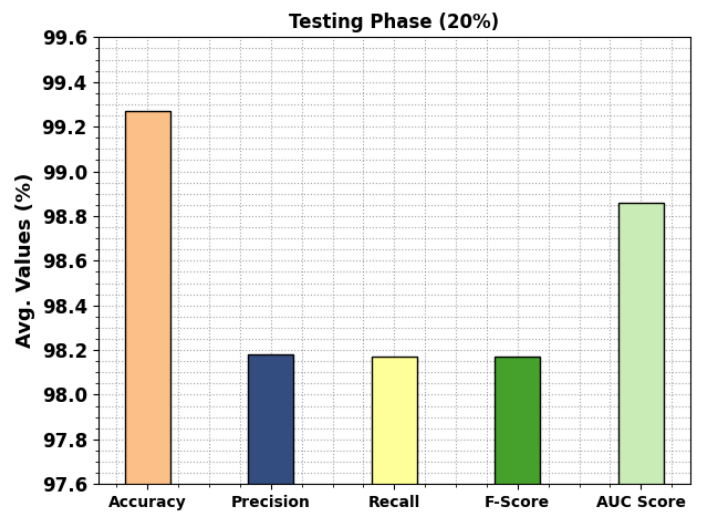
Figure 6. Average outcomes of MPADL-LC3 algorithm on 20% of TSS.